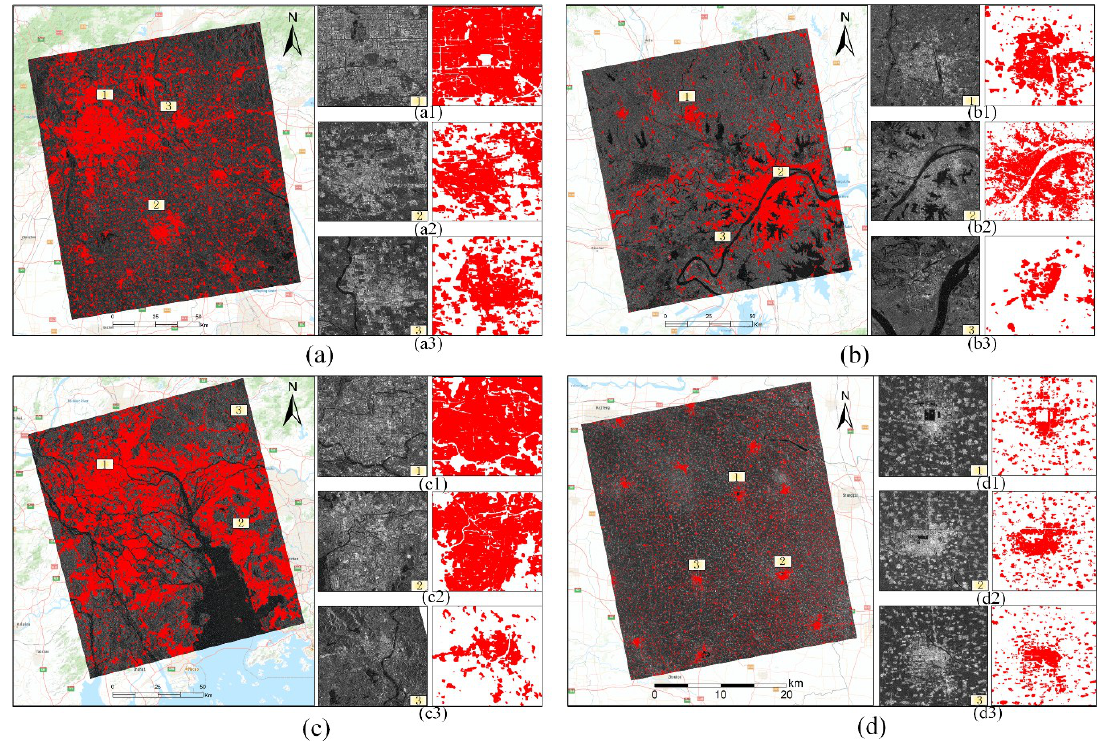
Figure 7. Extraction results based on the proposed model. ( a – d ) Extraction results of Beijing, Wuhan, Guangzhou and Shangqiu, respectively. Extraction results shown in red.